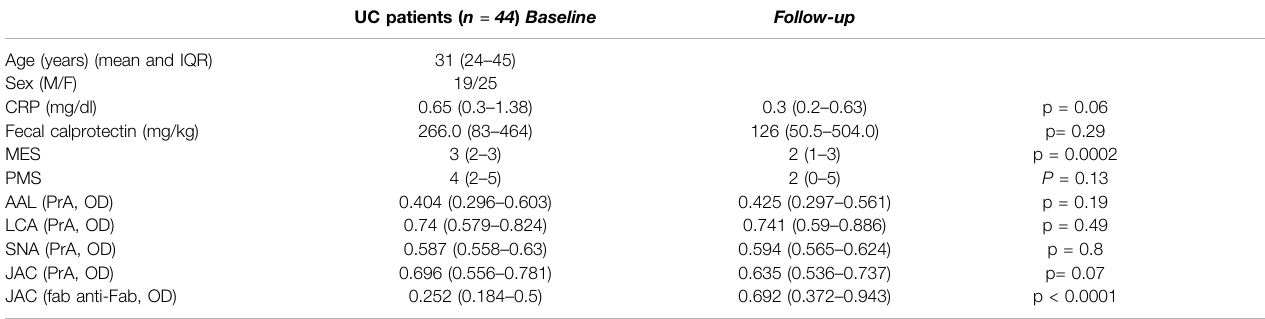
TABLE 1 | Demographic, clinical and serologic characteristics of patients ’ cohort. UC patients ( n = 44 )